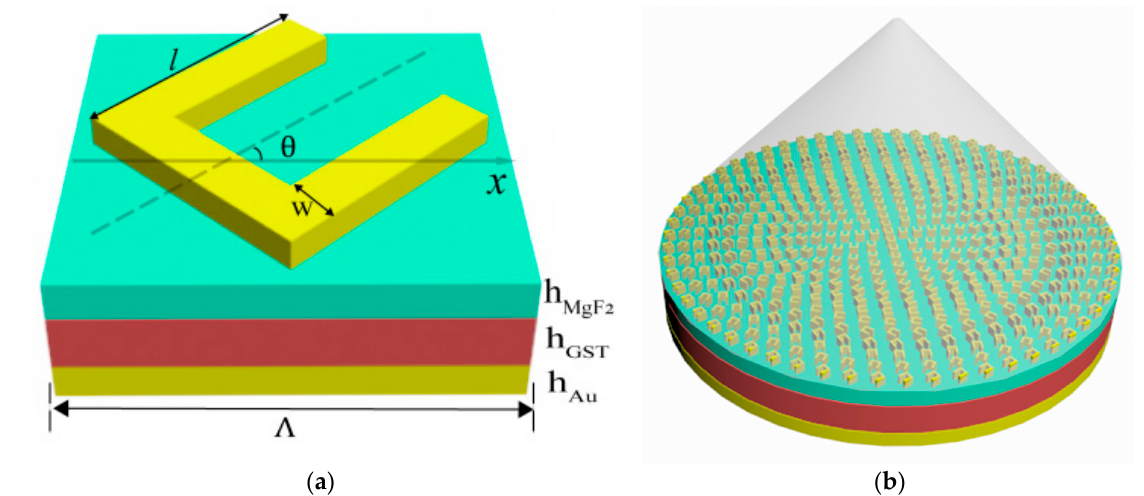
Figure 1. ( a ) The U-shaped atoms with rotated angle of θ to x -axis and ( b ) meta-surface lens by locally distributing all atoms with different angles.